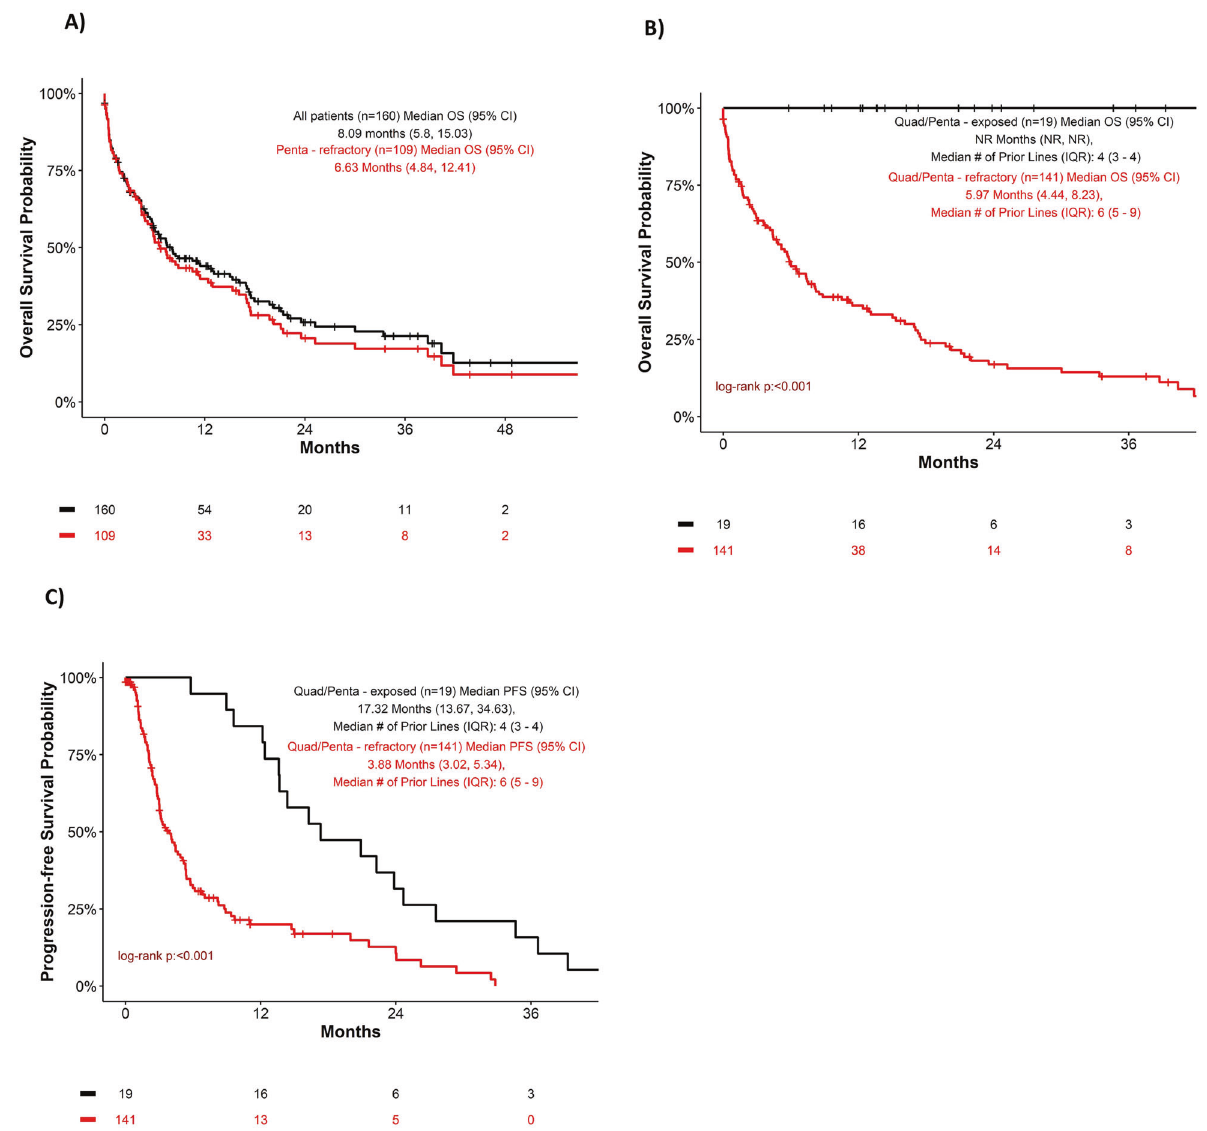
Fig. 1 Kaplan Meier curve. Overall OS ( A ), OS for quad/penta exposed versus quad/penta refractory ( B ), and PFS for quad/penta exposed versus quad penta refractory ( C ) OS = Overall survival; PFS = progression free